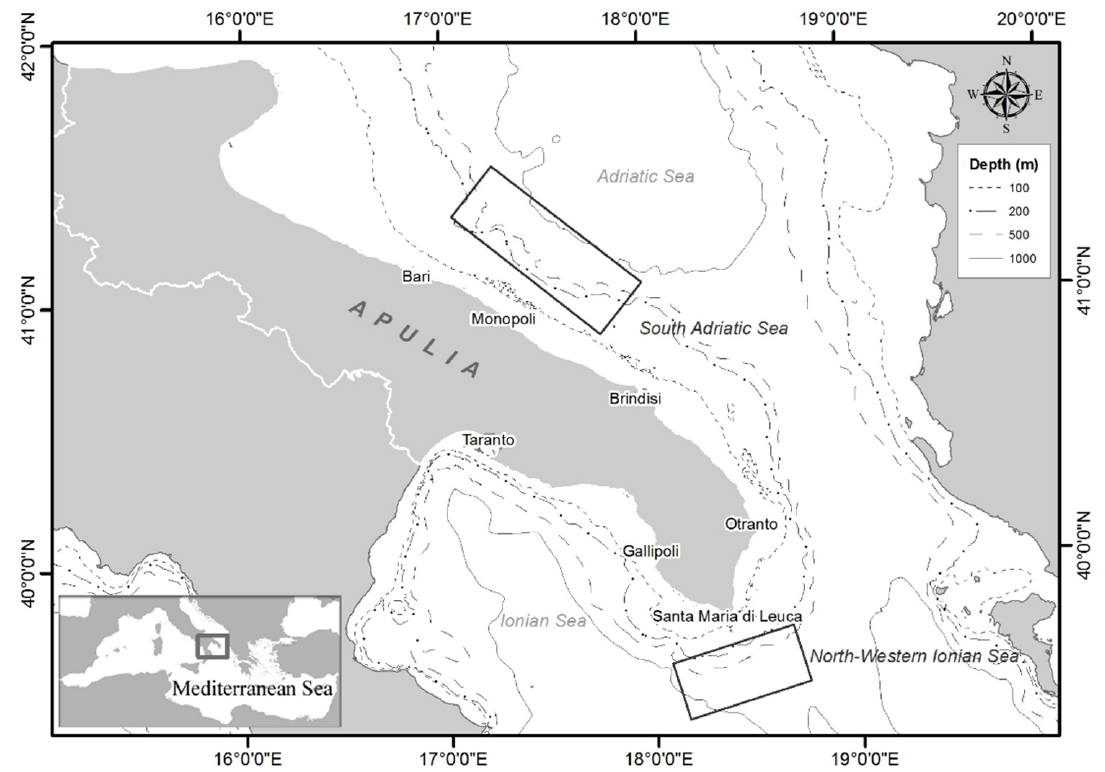
Figure 1. Map of the study area with an indication of the areas in which baited lander and longline were used.